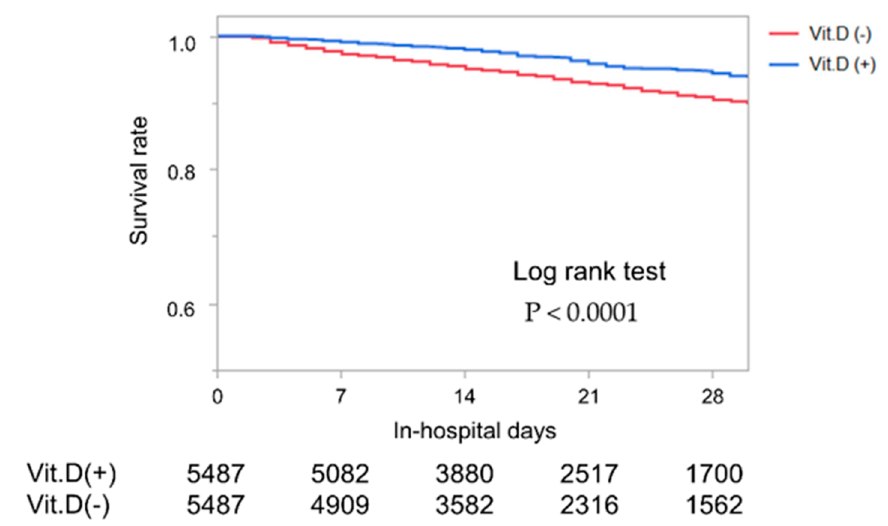
Figure 2. Kaplan Meier curves of in-hospital mortality and hospitalization days. Compar- ison between with and without vitamin D (Vit.D)